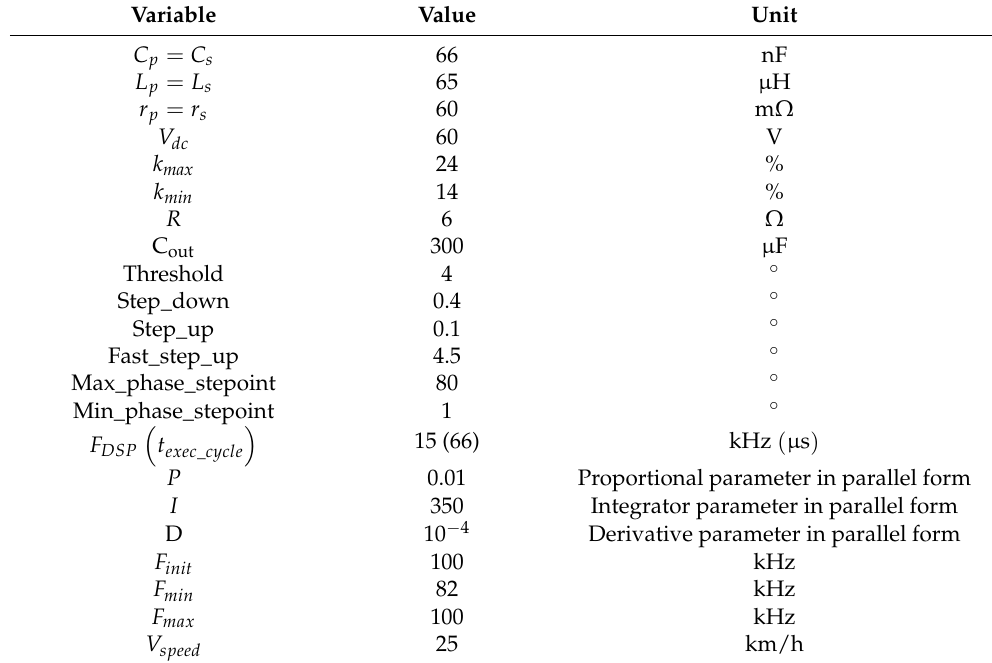
Table 4. System’s Table 4. System’s parameters.